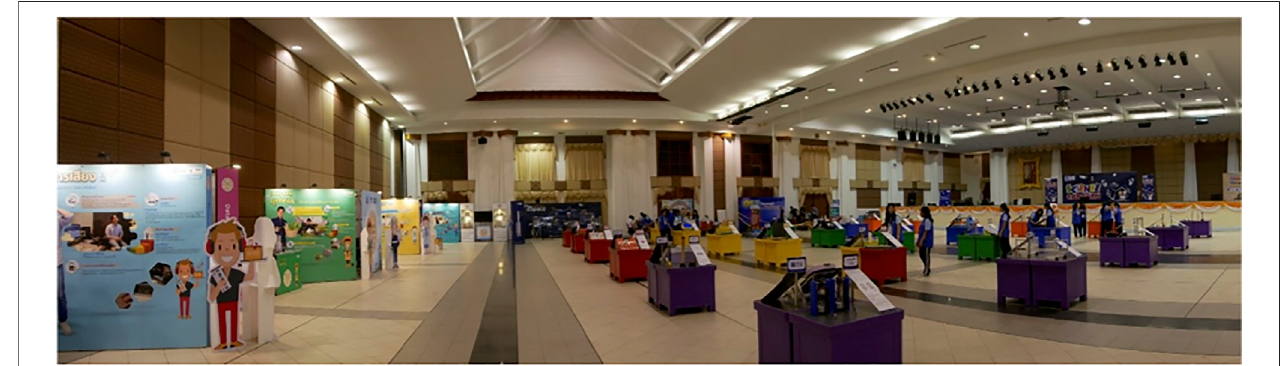
FIGURE 1 | A typical setting of the exhibition space of Science Caravan being prepared for opening to